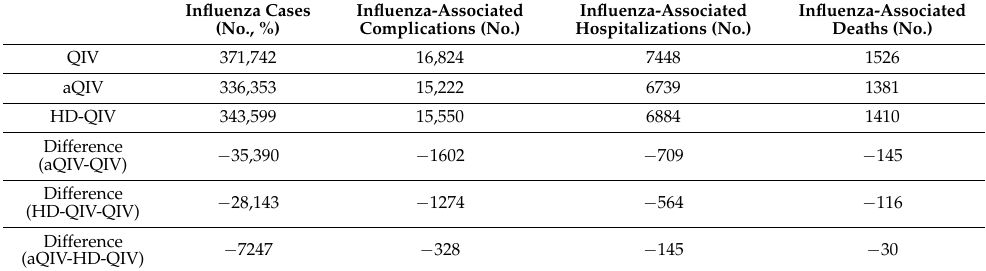
Table 3. Base-case one-year influenza disease burden comparisons of the three different QIVs. Influenza Cases (No.,